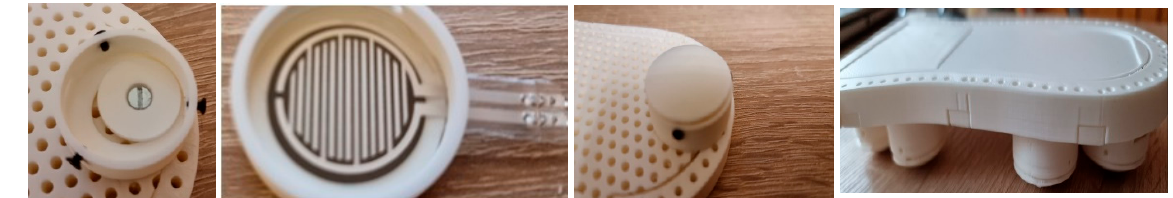
Figure 6. Sensor mounted on the sole of the sandal—prototype 3D printer, ABS—positioning detail using eccentric, sensor mounting detail in the housing.